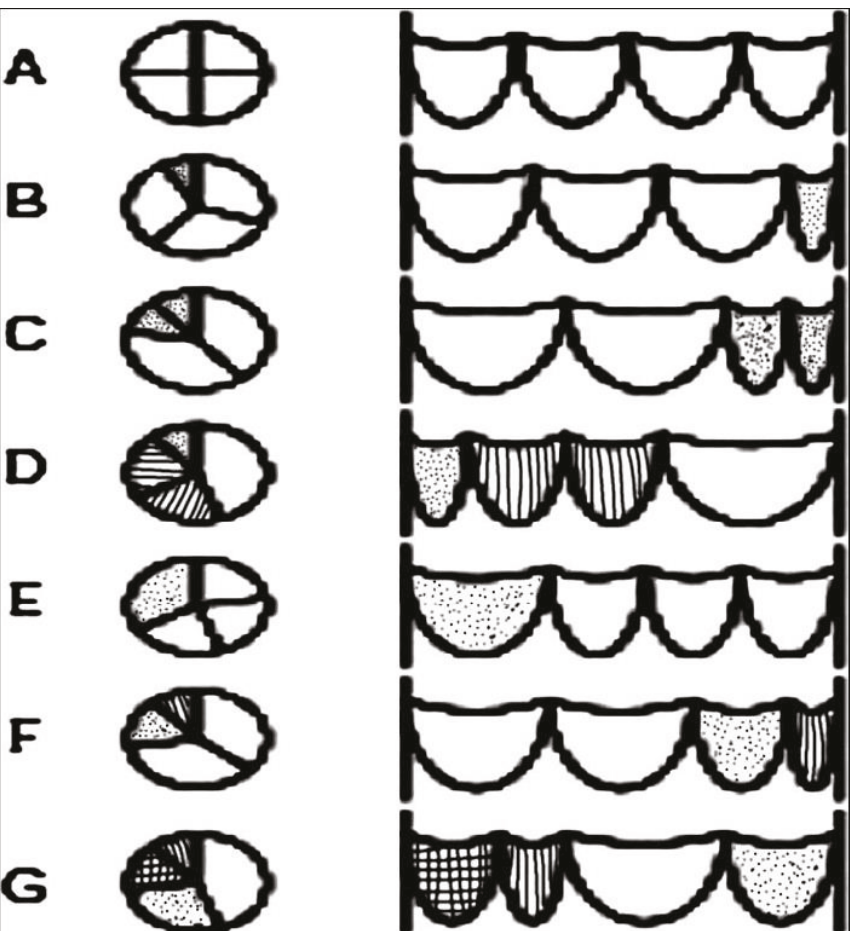
Figure 2: Hurwitz and Roberts classi fi cation of quadricuspid aortic valve.